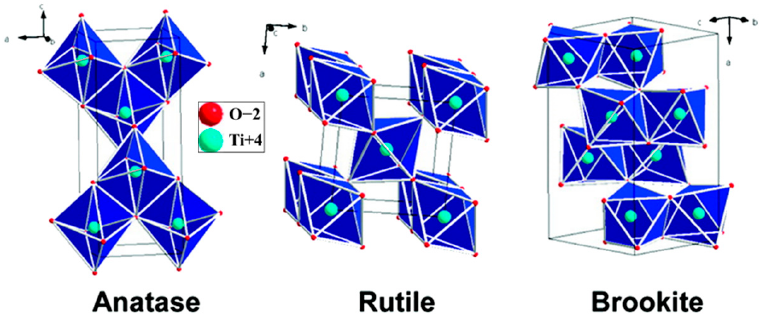
Figure 1. Representations of the TiO 2 anatase, rutile, and brookite forms [51]. Copyright 2014, American Chemical Society.